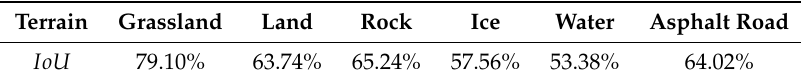
Table 9. IoU of each terrain.